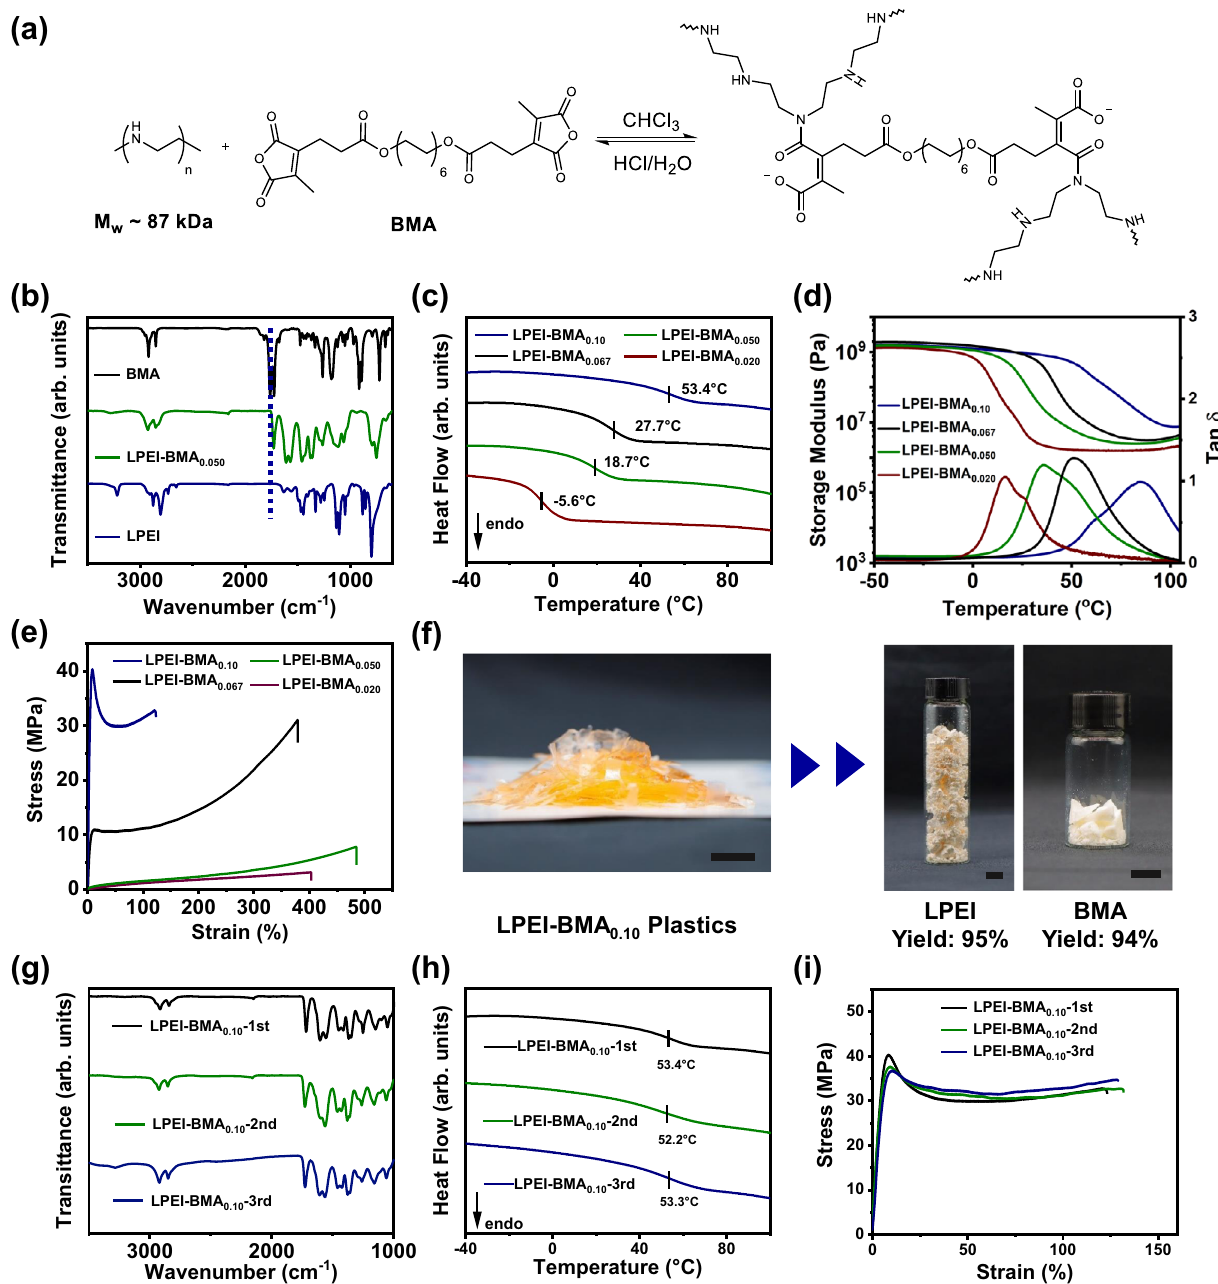
x between the cross-linkers and ethylene imine units. f Photographs of chemical recycling of the polymer network LPEI-BMA 0.10 into the feedstocks LPEI and BMA (scale bar: 1cm). g FT-IR spectra, h DSC curves, and i stress-strain curves of